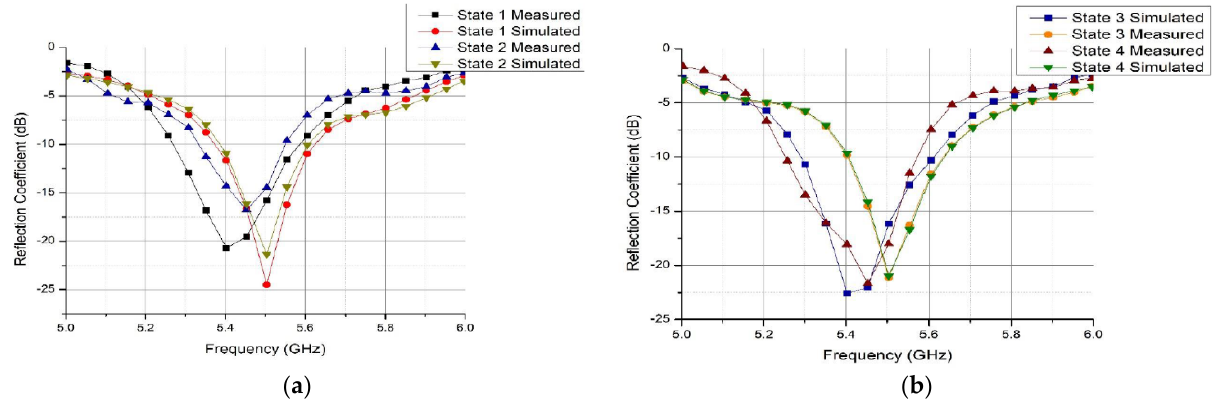
Figure 8. Fabricated Structure along with Biasing Network ( a ) Top-view ( b ) Bottom-view ( c ) DC Biasing Circuitry.